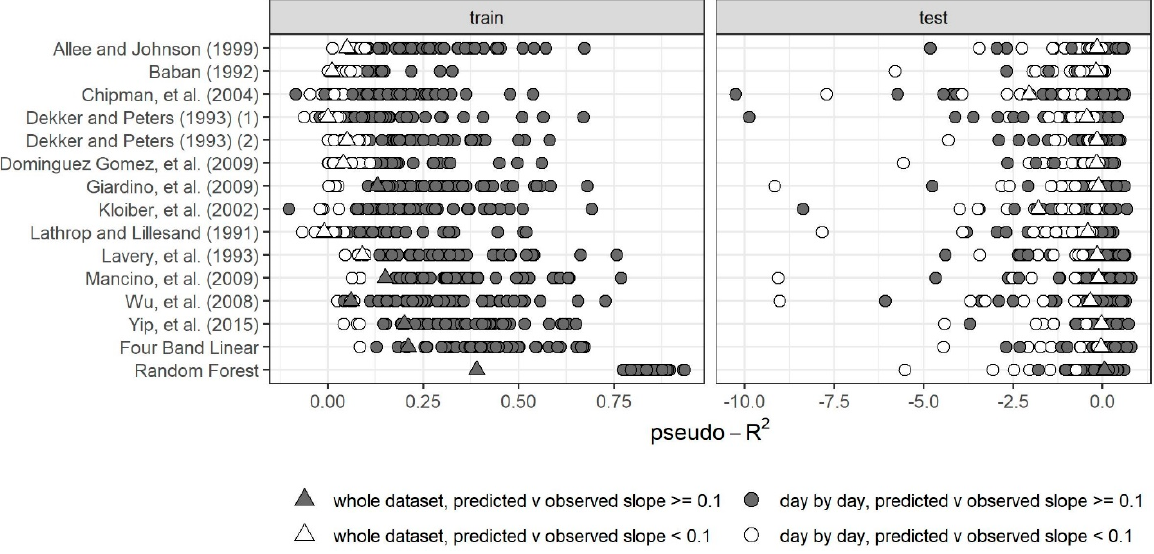
Figure 4. Pseudo-R 2 for the training ( left ) and test ( right ) subsets for the whole dataset (triangle) as compared to the day-by-day analyses (circles). Icons for the datasets are colored by the slope of the relationship between predicted and observed. Unfilled circles indicate a static predicted Secchi depth (predicted-observed slope < 0.1), gray fill indicates some response in the predicted Secchi depth such that there is a positive slope (>=0.1) in the relationship between predicted and observed Secchi depth. Note the difference in the x-axis scale between the two panels. This figure has been truncated at − 0.25 in the training set and − 11 in the test set, and in doing this, 3 points were excluded: the whole dataset training result for Chipman et al. (pseudo-R 2 : − 1.73) and Kloiber et al. (pseudo-R 2 : − 1.41) and a single-date model testing result for Kloiber et al. (pseudo-R 2 : − 44.71). A full-scale figure is included as Supplementary Figure S6. Table 2. Summary statistics for all algorithms created from the complete dataset of lake Secchi depths in ME, NH, VT, and NY, for both the training (n = 32,683) and testing (n = 3937) subsets. Pseudo-R 2 was calculated as